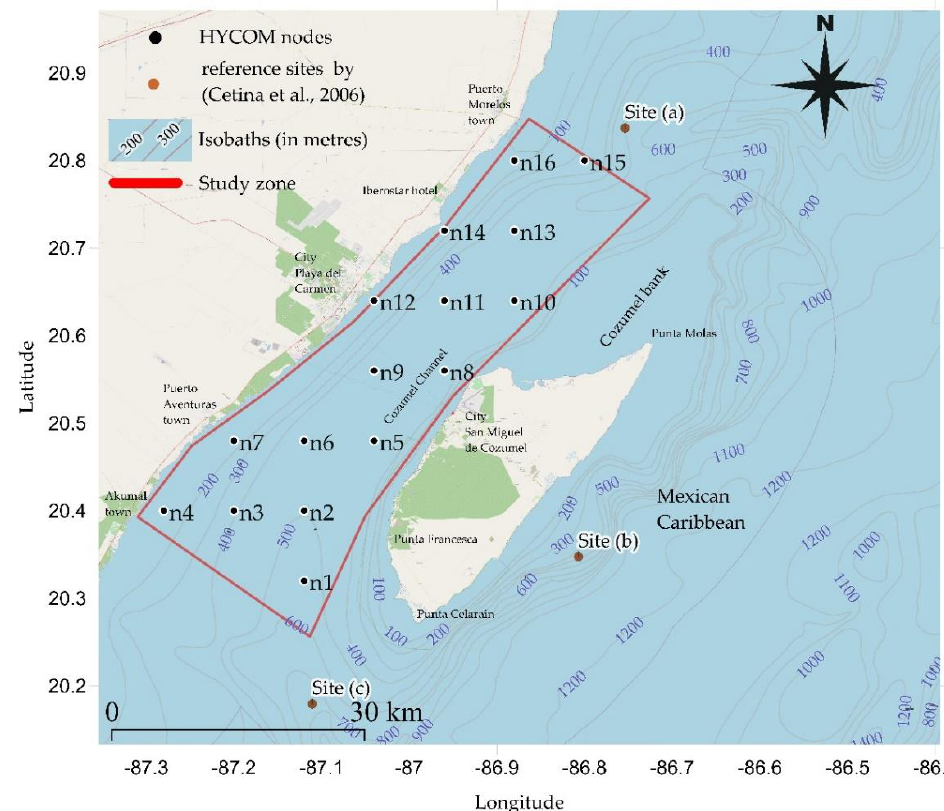
Figure 5. Bathymetric view of the Cozumel channel. Taken from sheet 1-06 from [44]. The red line shows the study area, in which 16 HYCOM nodes (n1 to n16) are plotted. Sites (a), (b) and (c) are those evaluated by [40].